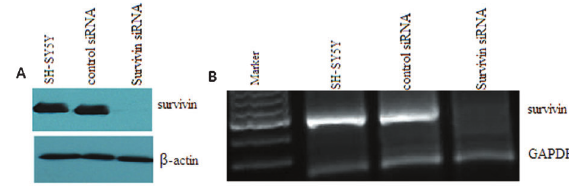
Figure 2. Alterations in survivin mRNA and protein levels in SH- SY5Y cells after stable transfection with survivin siRNA or control siRNA. A , Western blotting for examining expression of survivin protein. Western blots were reprobed for b -actin content to demonstrate that all lanes were loaded with equal amounts of protein. B , RT-PCR analysis for survivin mRNA expression. The expression of GAPDH mRNA was used as an internal control.